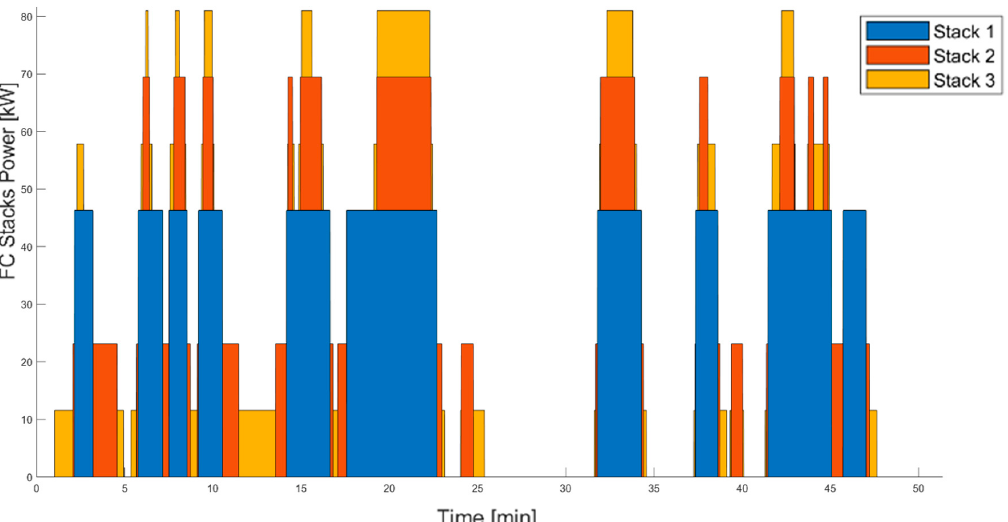
Figure 9. Power profile of the FESS bench.